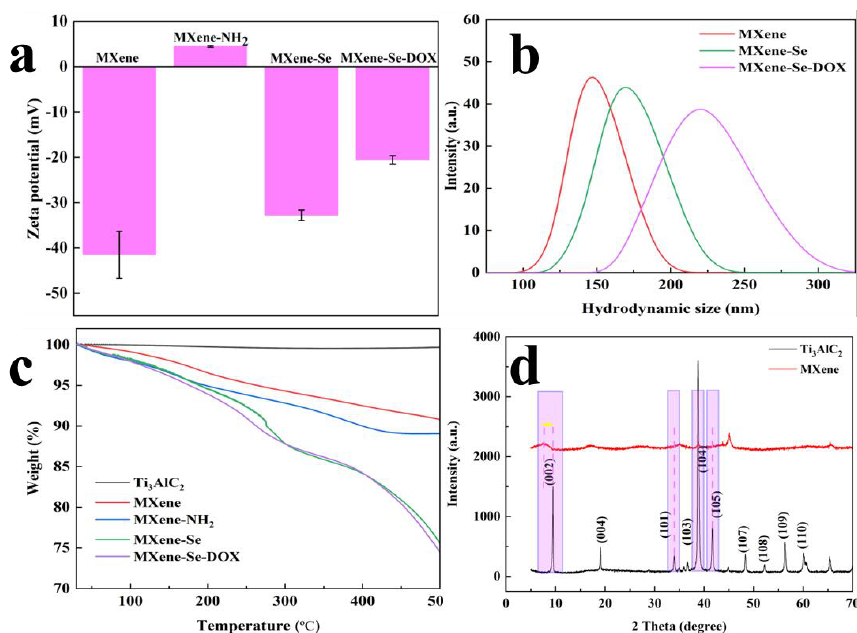
Figure 2. ( a ) Zeta-potential analysis of pristine MXene and functionalized MXene nanosheets. ( b ) Hydrodynamic diameters of MXene, MXene-Se, and MXene-Se-DOX nanosheets. ( c ) TGA curves of Ti 3 AlC 2 , MXene, MXene-NH 2 , MXene-Se, and MXene-Se-DOX nanosheets. ( d ) XRD patterns of Ti 3 AlC 2 and MXene flakes.